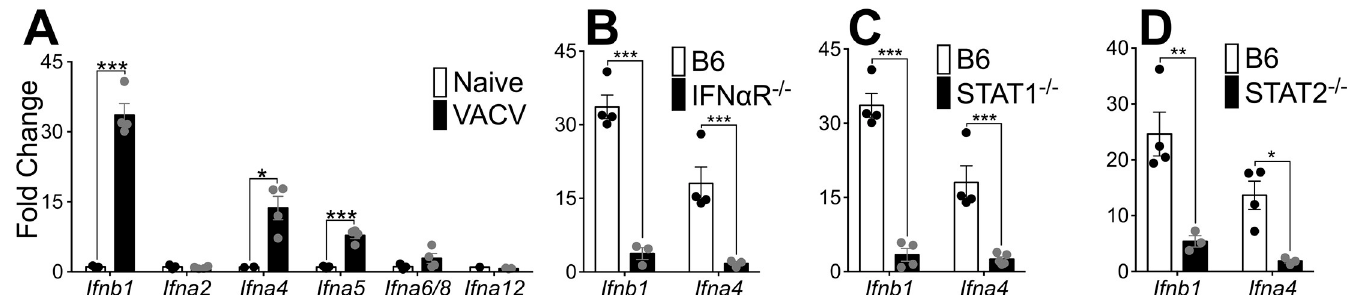
Fig 2. A positive feedback loop is required for T1-IFN production in response to VACV. (A) Expression of T1-IFN subtypes in ear tissue of wild-type mice 5 dpi measured by RT-qPCR. (B-D) Expression of early T1-IFNs in ear tissue of mice 5 dpi measured by